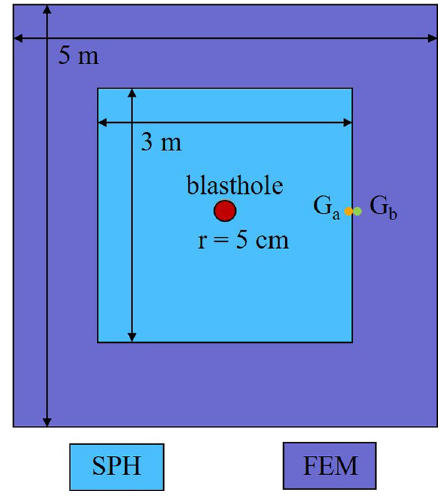
Fig. 6 Plane model for SPH-FEM